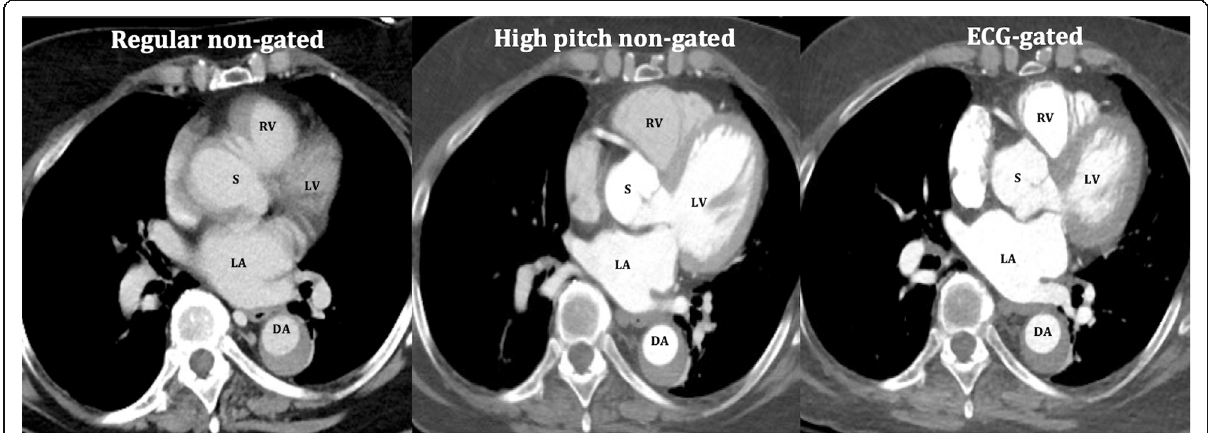
Fig. 1 A 67-year-old man with medically managed type B aortic dissection and metastatic colon cancer. Conventional non-ECG-gated CT chest image, high-pitch non-ECG-gated CT image, and ECG-gated CTA image highlighting improved visualization of heart and proximal aortic structures with high-pitch exam even without ECG gating. Abbreviations: LA, left atrium; LV, left ventricle; RV, right ventricle; S, sinus of Valsalva; DA, descending thoracic aorta